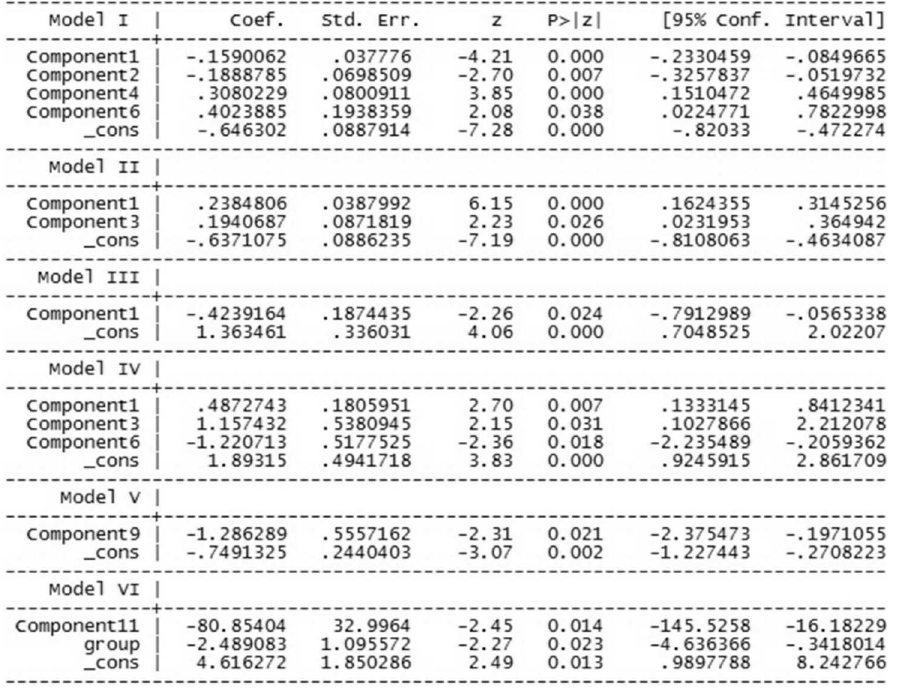
ROC curve (ability of model to differentiate positive and negative results) was